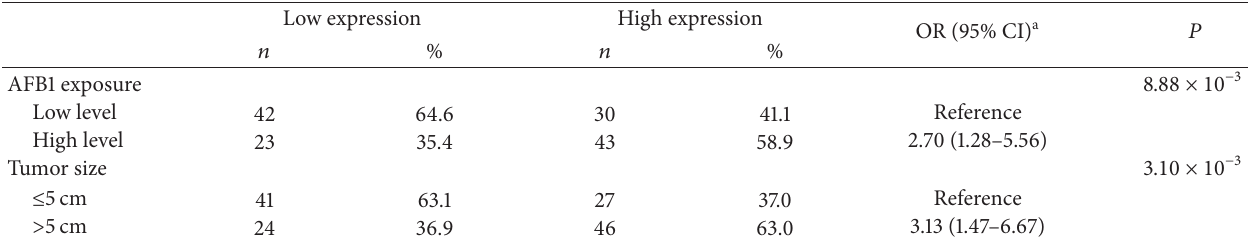
Figure 1: MiR-429 expression correlated with HCC tumorigenesis. (a) MiR-429 expression was evaluated in the tumor tissues, compared with in the adjacent noncancerous tissues. The relative expression of miR-429 is shown as box plots, with horizontal lines representing the median, the bottom, and the top of the boxes representing the 25th and 75th percentiles, respectively, and vertical bars representing the range of data. We compared the difference among groups using the Student 𝑡 -test. (b) MiR-429 expression was higher in cancer cell line SMMC-7721 than in noncancer cell line QSG-7701. Table 2: Expression levels of miR-429 and AFB1 exposure levels and tumor size of